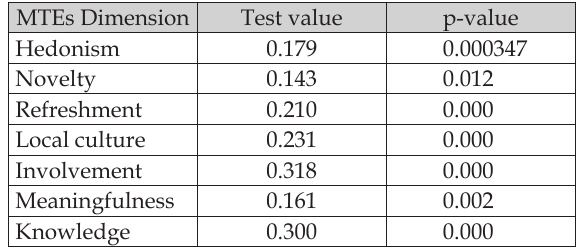
Table 6. Normality of the indices in the research